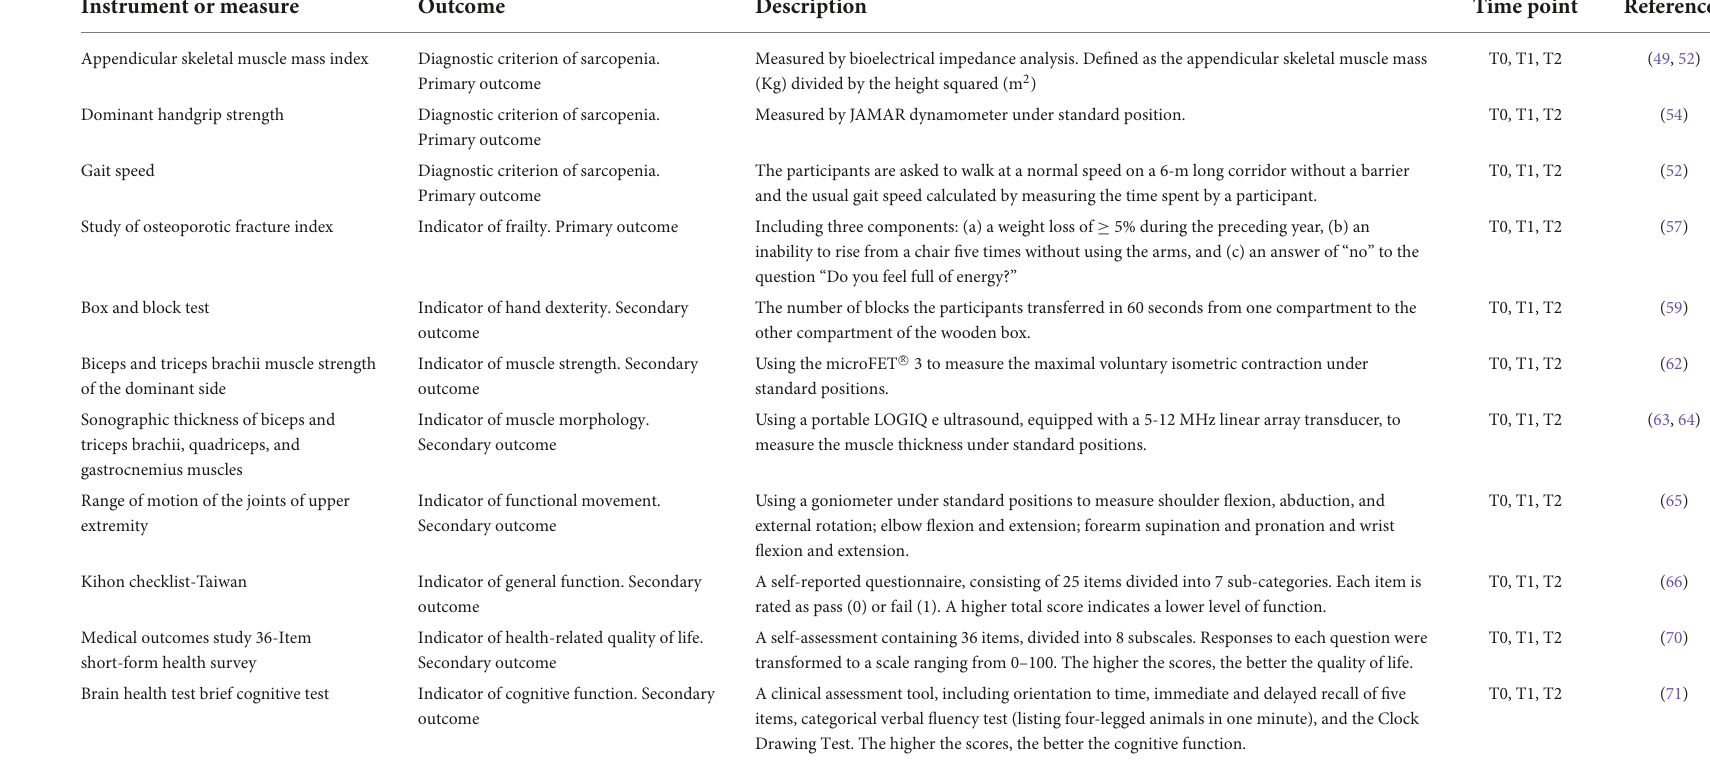
TABLE 2 Instruments and measures to be implemented for data